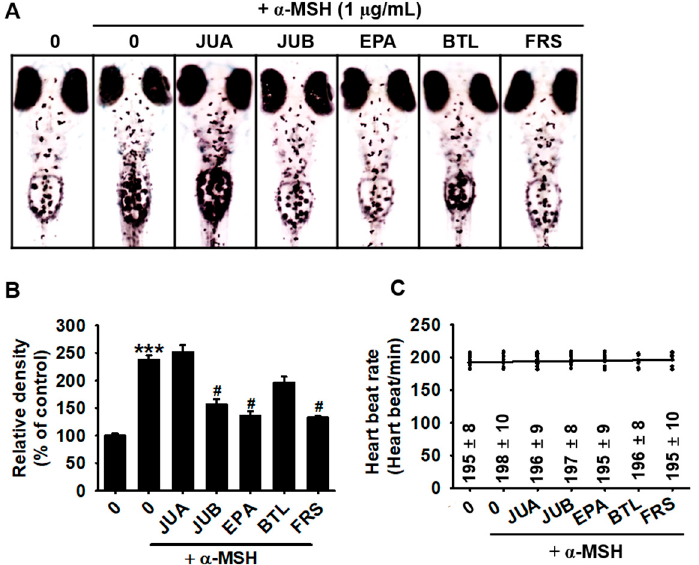
Figure 4. JUB, BTL, and FRS from Z. jujuba var. inermis (Bunge) Rehder seeds inhibit α -MSH-induced pigmentation in zebrafish larvae. ( A ) Zebrafish larvae at 3 dpf ( n = 20 in each group) were treated with 20 µM of jujuboside A (JUA), jujuboside B (JUB), epiceanothic acid (EPA), betulin (BTL), and 6’’’-feruloylspinosin (FRS) for 72 h in the presence and absence of 1 µg/mL of α -MSH. (A) Images of zebrafish larvae were captured using a stereomicroscope (×4). ( B ) Relative melanocyte densities of zebrafish larvae were calculated using ImageJ software. ( C ) Heart beats were manually counted and expressed as heart beats/min. All data are presented as a standard error of the median (*** p < 0.001 vs. untreated zebrafish larvae; # p < 0.05 vs. α -MSH treated zebrafish larvae).